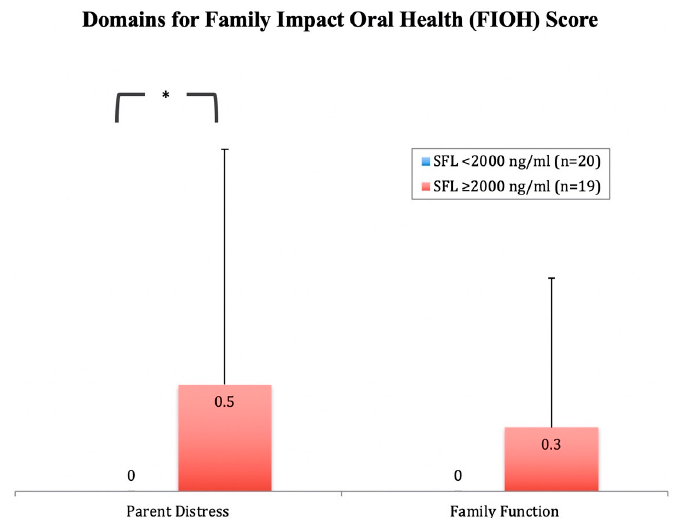
β -thalassemia major (BTM) participants with serum ferritin level (SFL) < 2000 ng / mL (n = 20) and with SFL ≥ 2000 ng / mL (n = 19). A significant di ff erence between the groups was detected in the domain “Parent Distress” using the Mann–Whitney U test ( p ≤ 0.05). * Statistically significant at the 0.05 level using the Mann–Whitney U test.